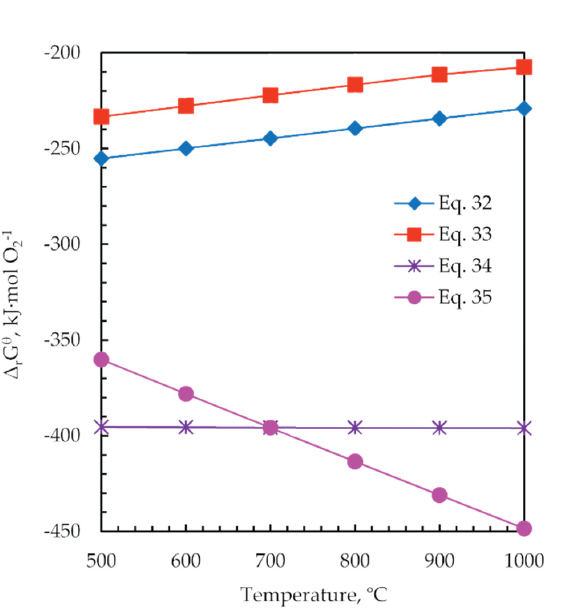
Figure 14. The change in standard Gibbs free energy ( ∆ r G θ ) versus temperature for the reactions during the roasting process Equations (32)–(35).